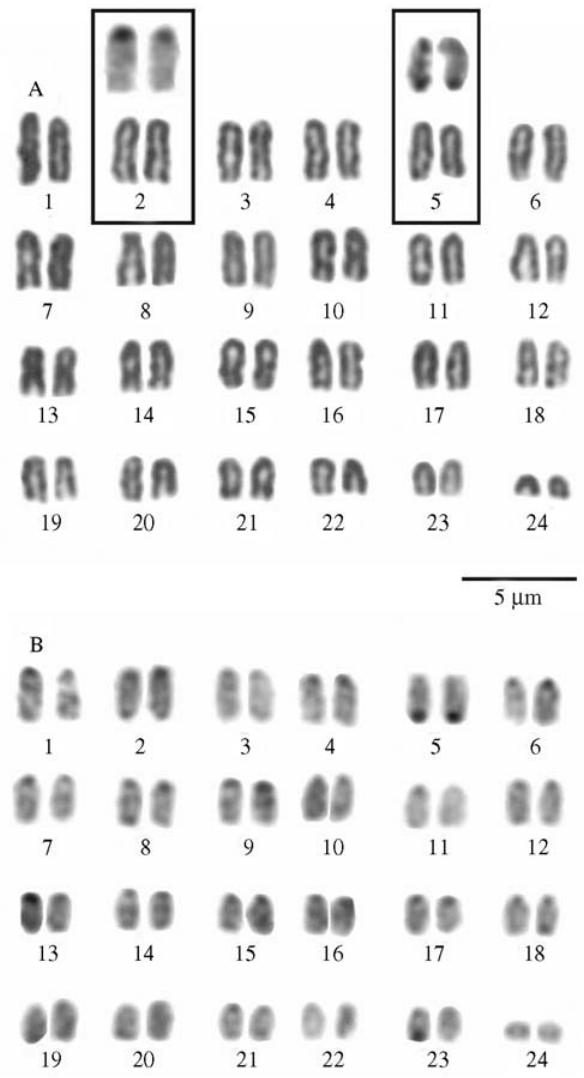
Figure 2 - Karyotype of Lutjanus alexandrei. (A) Conventional Giemsa staining. In detail, the secondary constrictions equivalent to NORs. (B) C-banding in L. apodus .